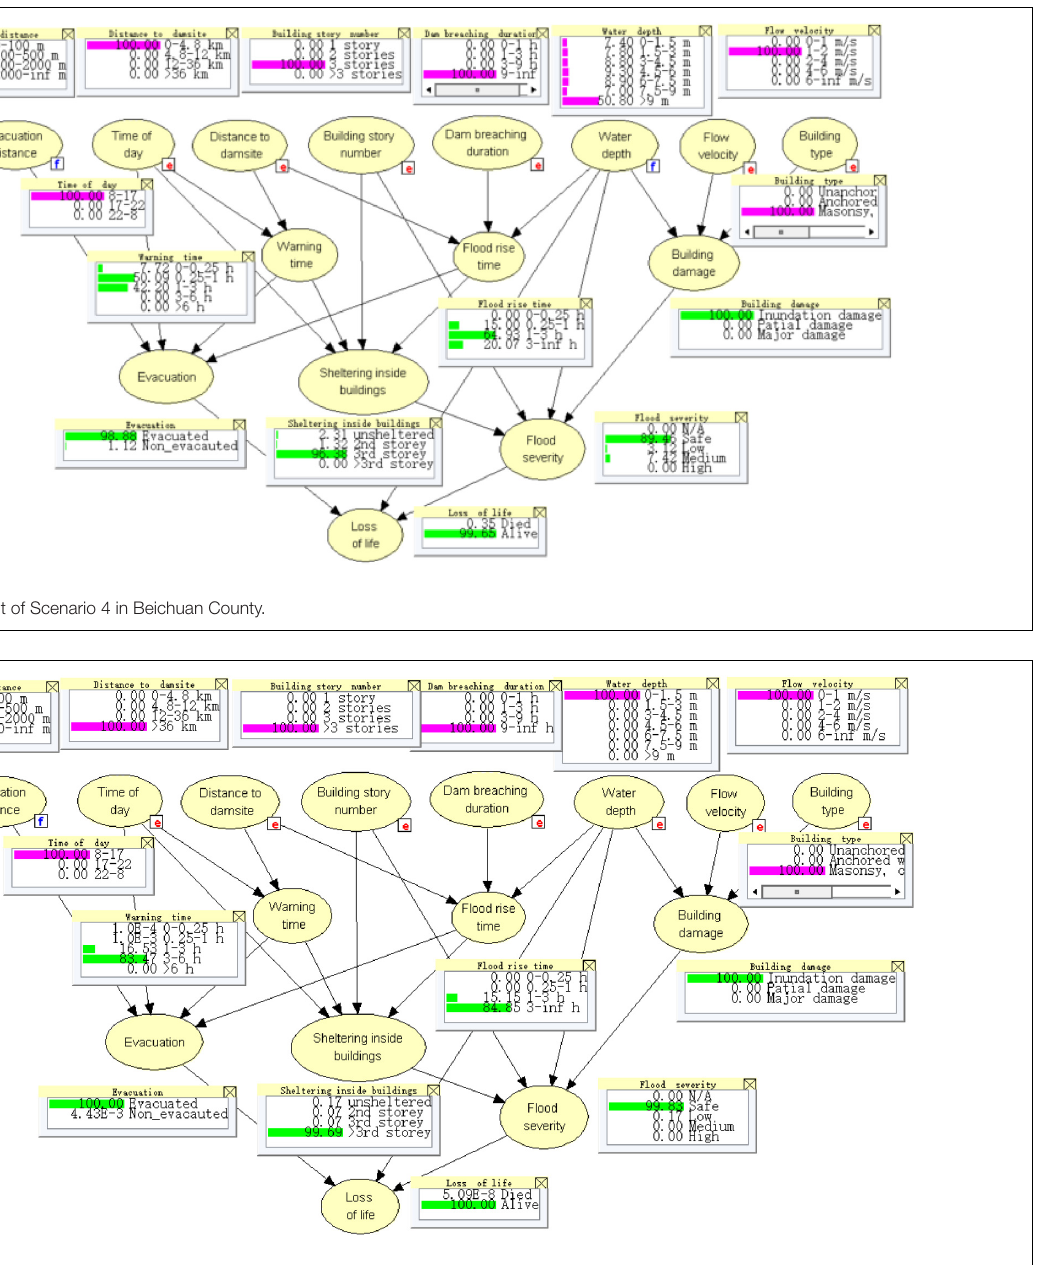
FIGURE 3 | Risk assessment of Scenario 4 in Mianyang